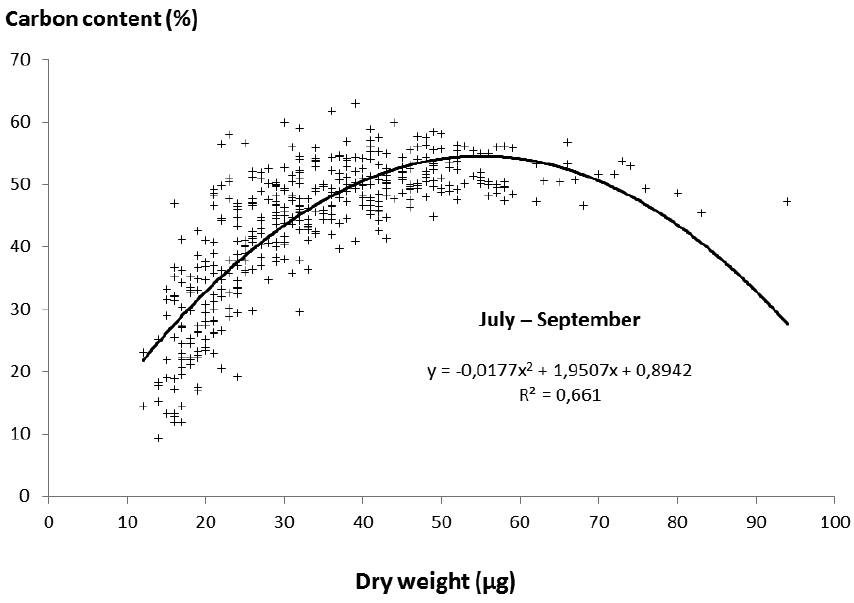
Figure 4. Relationship between carbon content (%) and dry weight (µg) of Cercopagis pengoi in July– September ( n